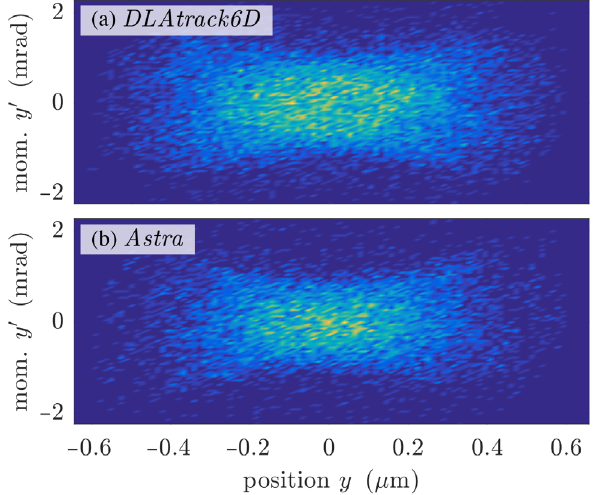
546 μ m asyn- und ¼ FIG. 16. Comparison of vertical phase space from DLA track6 D and ASTRA at z ≈ 9 . 3 mm in the asynchronous DLA undulator 546 μ lattice for λ und ¼